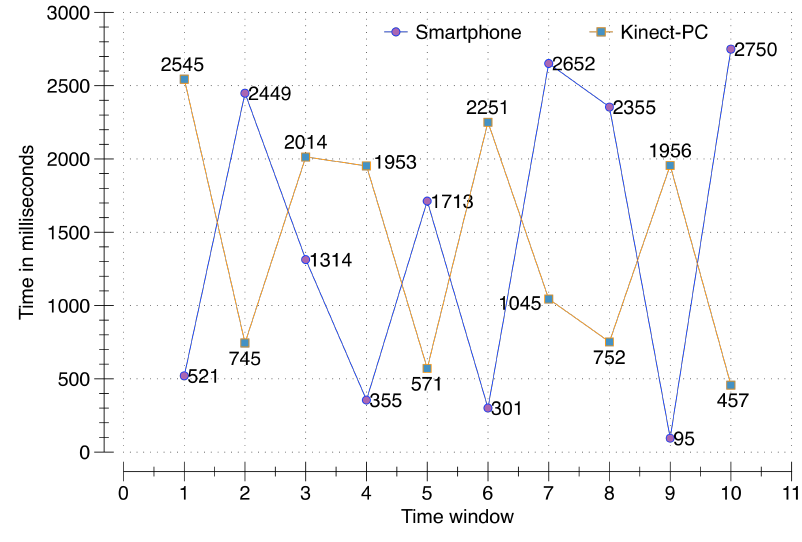
Figure 7. Data synchronization testing per